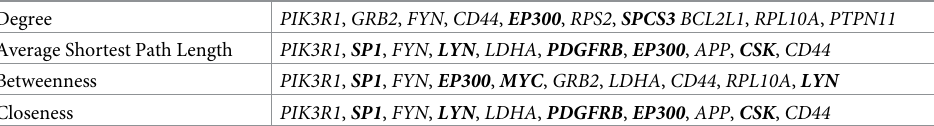
Table 3. Nodes with top centrality values in the largest connected